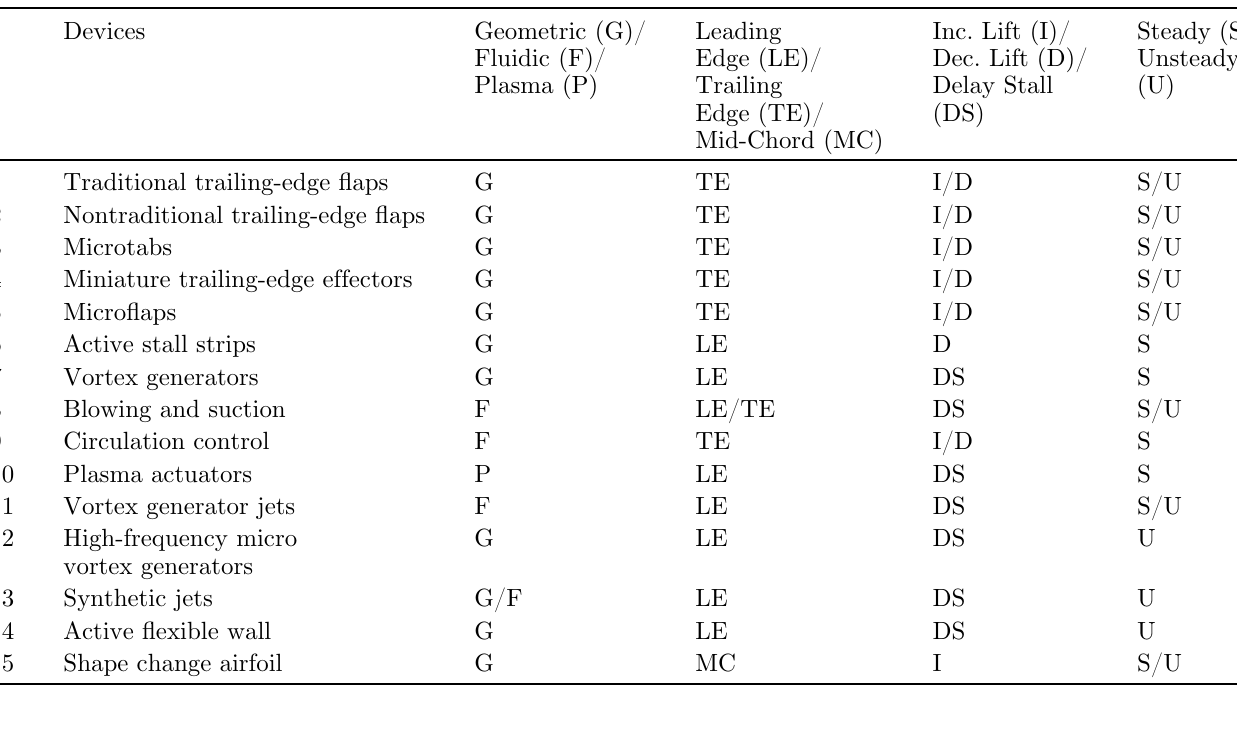
Table 1. Classi fi cation chart for AFC techniques [7].